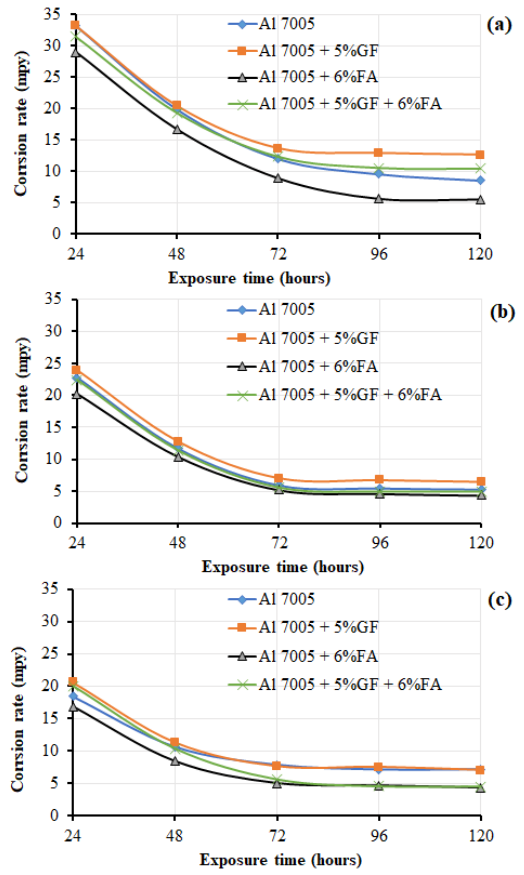
Figure 4. Effects of exposure time on the corrosion rate of Al 7005 and its composites: ( a ) as-cast, ( b ) 2.66:1 of ER and ( c ) 5.32:1 of ER.